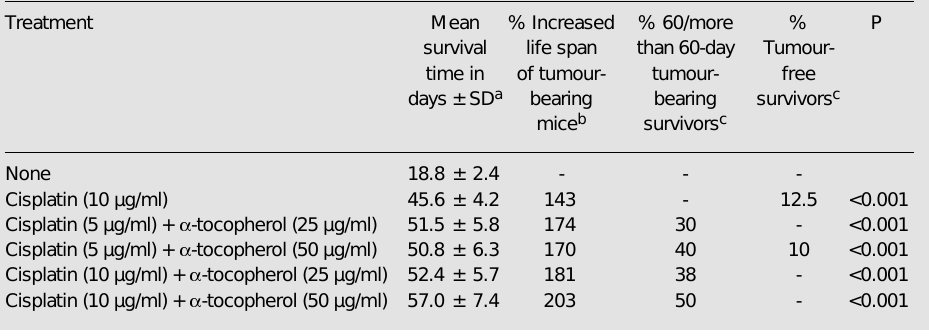
Table 3 - Platinum content in kidney and tumour after treatment with cisplatin alone or in combination with a -